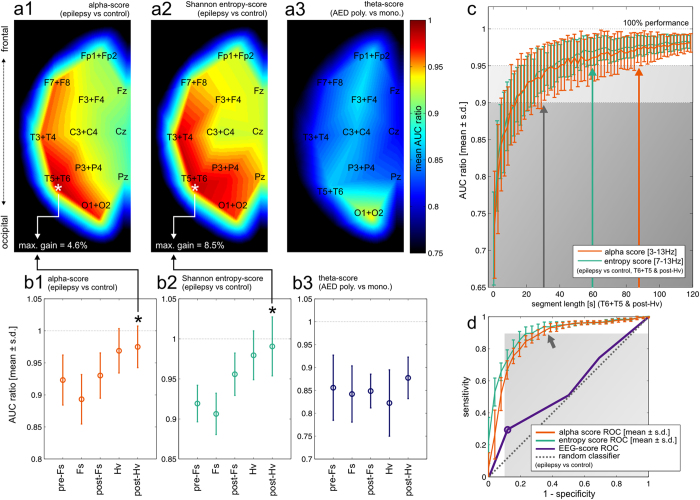
Trends in the optimization of alpha-, Shannon entropy- and theta-score based classifiers.Note that AUC values and ROC curves displayed in this figure serve only to illustrate trends in the process of optimisation instead of being results of cross-validation (which are summarized in Table 2). The results are displayed as AUC ratios (see Results). (a1–a3) The distributions of mean AUC ratios over EEG channel positions. It can be seen that alpha- and Shannon entropy-scores perform best for temporal-occipital leads (white asterisks) while the theta-score performance is uniformly reduced across individual channels with the exception of O2 + O1. (b1–b3) The dependence of mean AUC ratios on the recording segments. For alpha- and Shannon entropy-scores performance increases towards the end of the recording with a maximum in the post-Hv segment (black asterisks). (c) The expected dependence of performance (alpha- and Shannon entropy-scores) on segment length (T6 + T5 & post-Hv, 1–120 s). 100% performance refers to “naive” AUC obtained for the full-length segment. Grey shaded areas correspond to 90% and 95% performance and arrows indicate the minimum segment lengths for which respective performance levels are reached (see Results for details). (d) Averaged ROC curves (see Results for details) for alpha- and Shannon entropy-scores (red and green curves respectively). The ROC curve associated with the EEG-score is shown for comparison (violet curve, the circle represents classification based on the presence of IEDs). The grey shaded area corresponds to sensitivity or specificity <90%. Interval spectrum-based markers achieve >90% sensitivity for ~60–70% specificity (arrow).